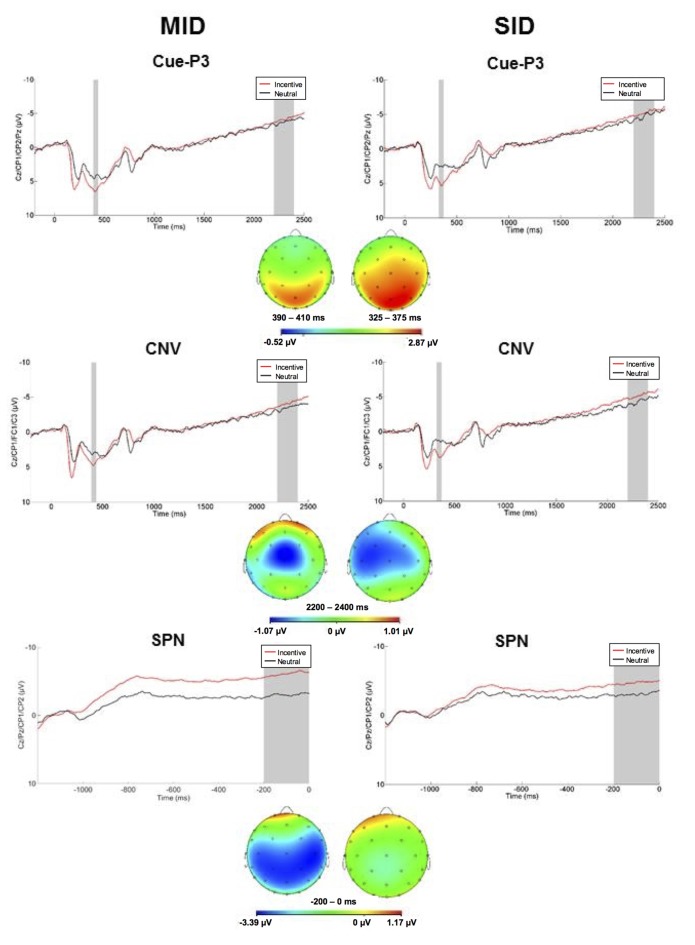
Left column: anticipatory ERP responses to monetary incentive and neutral trial conditions on MID. The cue-P3 was scored as the average activity in the first shaded window (top row: 390–440 ms) and the contingent negative variation (CNV) in the second shaded window (middle row; 2,200–2,400 ms). The stimulus preceding negativity (SPN; bottom row; −200 to 0 ms prior to feedback onset) was scored as the average in the shaded window. Right column: anticipatory ERP responses to social incentive and neutral trial conditions on SID. The cue-P3 was scored as the average activity in the first shaded window (top row: 325–375 ms) and the CNV in the second shaded window (middle row; 2,200–2,400 ms). The SPN (bottom row; −200 to 0 ms prior to feedback onset) was scored as the average in the shaded window. Below each waveform is the scalp distributions of the difference between incentive and neutral trials for the cue-P3 (top), CNV (middle), and SPN (bottom) for MID and SID.